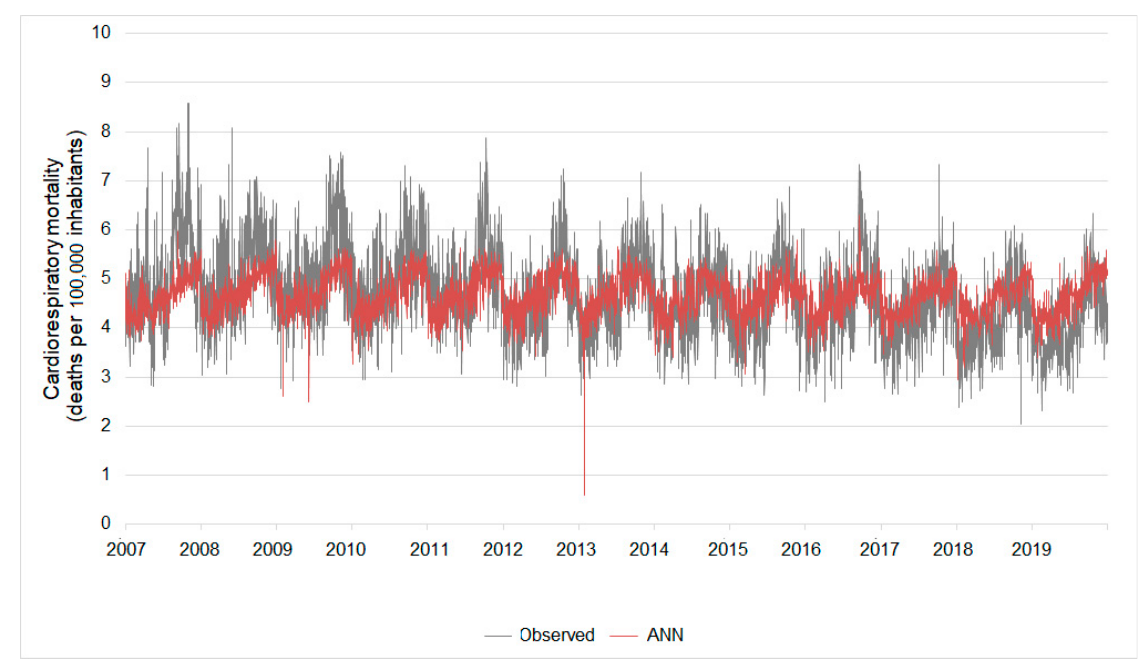
Figure 5. Real daily cardiorespiratory mortality versus that estimated by the Model I ANN. Results considering the ANN build from the entire database (considering rainy and dry seasons).